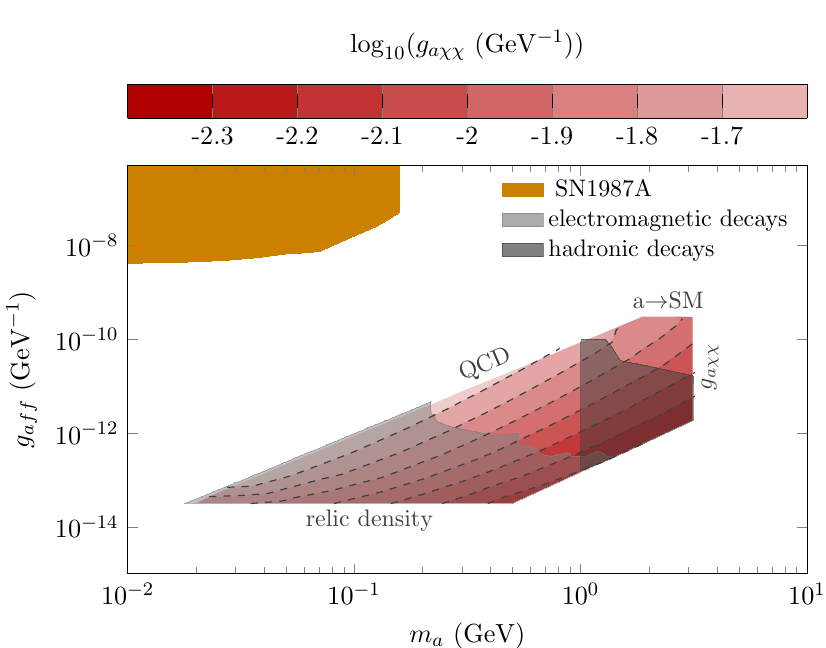
Figure 8 . Contour plot of the hidden-sector couplings g aχχ in the ( m a , g aff ) -plane which give the observed DM relic density via decoupled freeze-out (DFO). We fixed the ratio m We have included the relevant constraints on our ALP model on the connector coupling g this parameter region (cf. figure 3). We additionally plot the region excluded by cosmological con- straints of additional particles decaying electromagnetically (light grey) and decaying hadronically (dark grey). For explanations about the boundaries of the DFO region and the constraints from electromagnetic and hadronic decays see the main